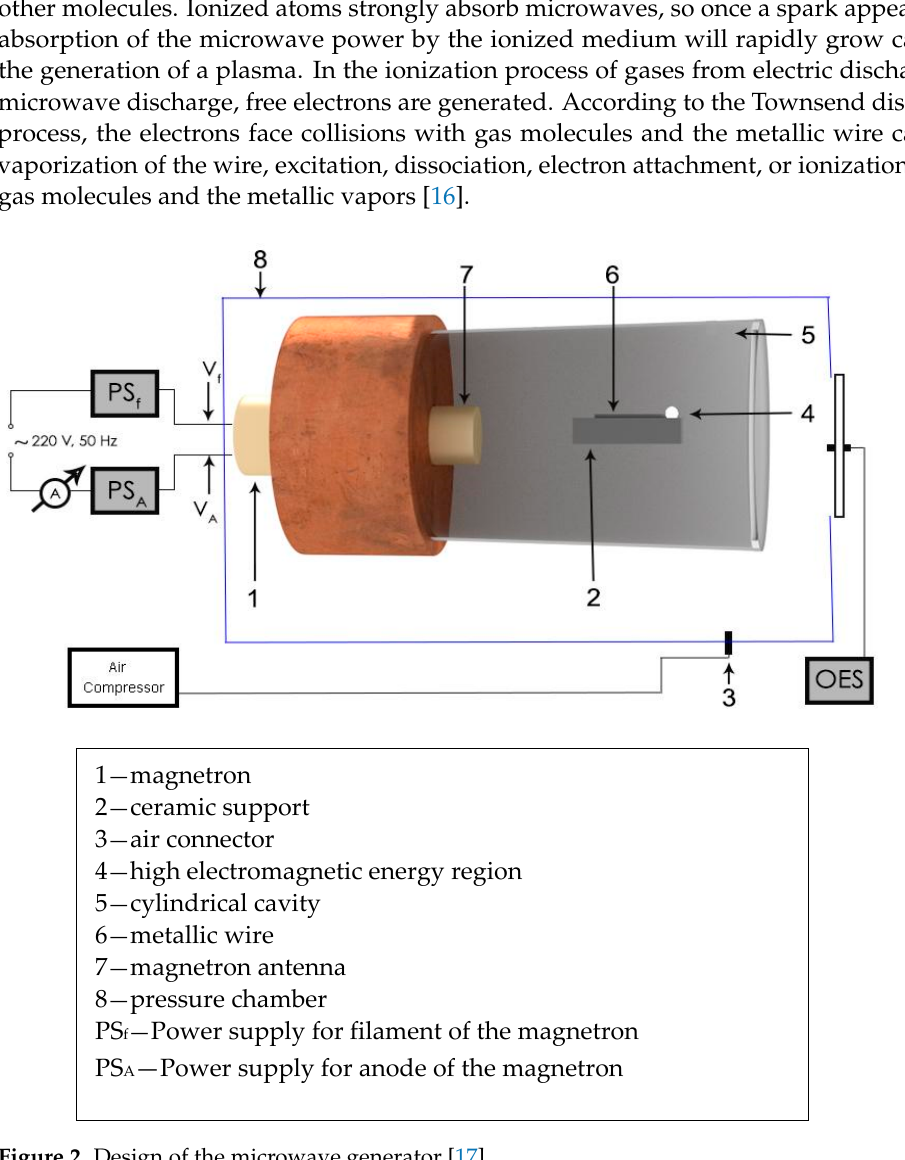
Figure 2. Design of the microwave generator [17].